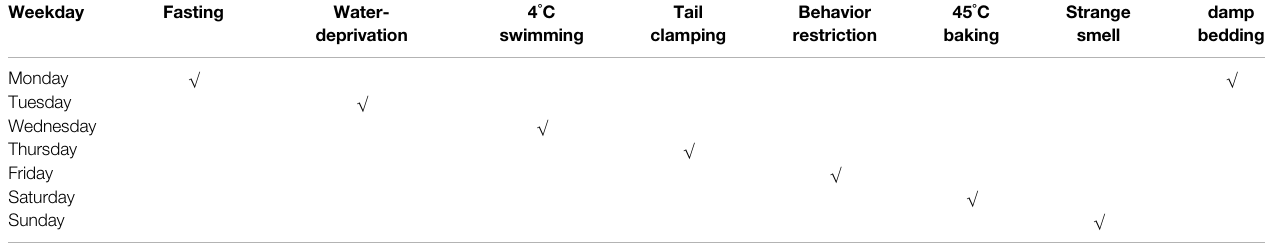
TABLE 1 | CUMS random stress timetable.